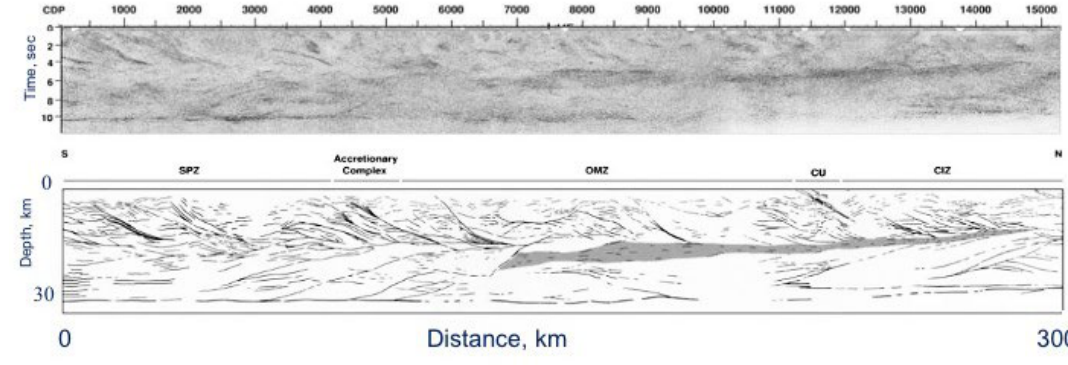
Figure 12. IBERSEIS deep seismic reflection profile tracing a prominent midcrustal reflection sequence beneath the Iberian Massif [74]. Top: time migrated seismic section. Bottom: line drawing.